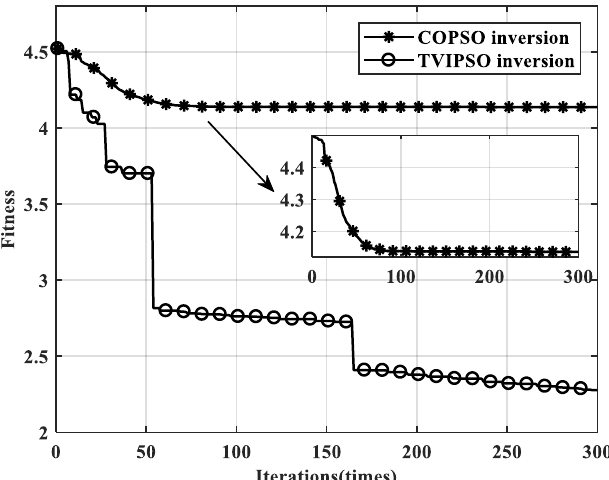
Figure 15. Convergence curves of fitness functions for COPSO inversion and TVIPSO inversion algorithms. Table 4. Comparison of the iteration details for the two inversion methods.